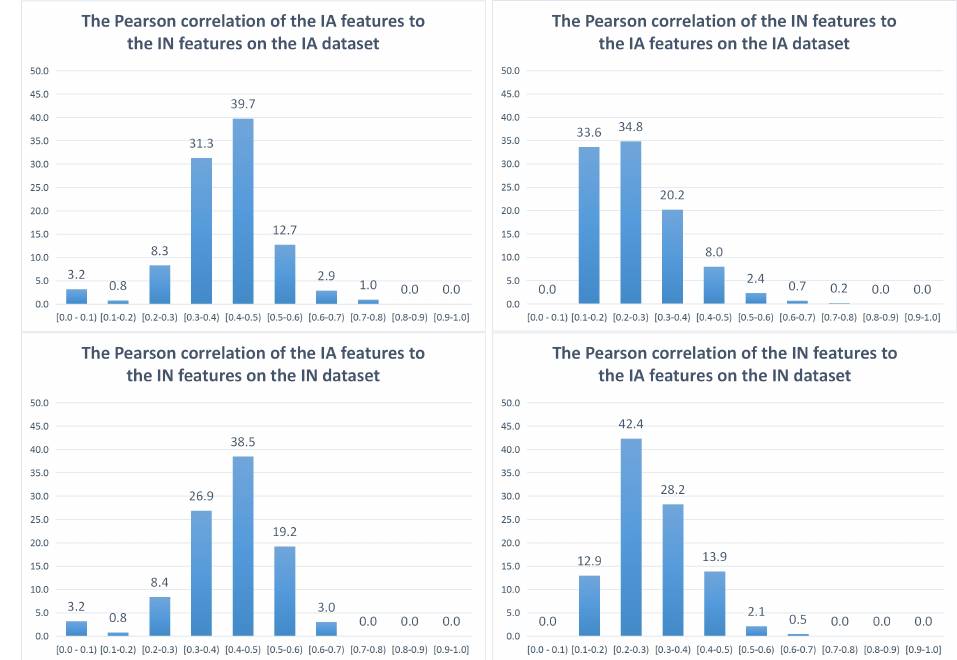
Figure 4. Pearson correlation between IA features and IN features.